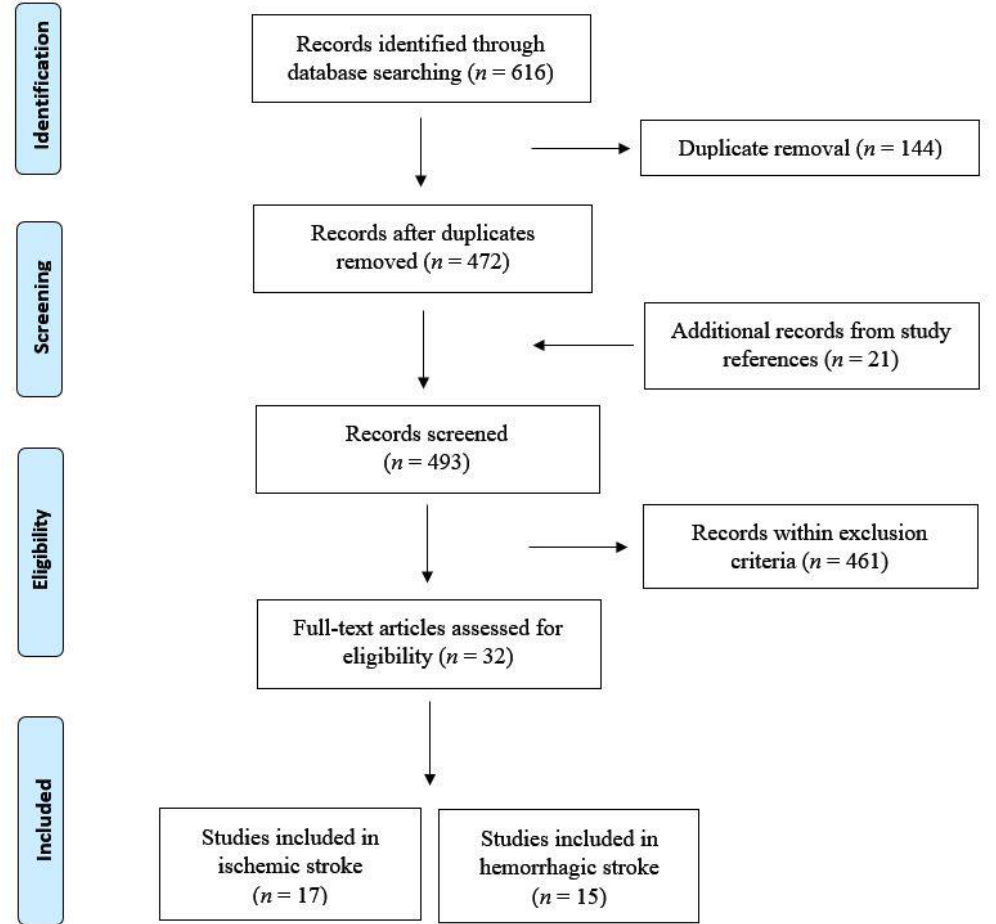
Figure 1. Flow diagram showing the search strategy, the number of records identified, and the numbers of included and excluded studies [58].